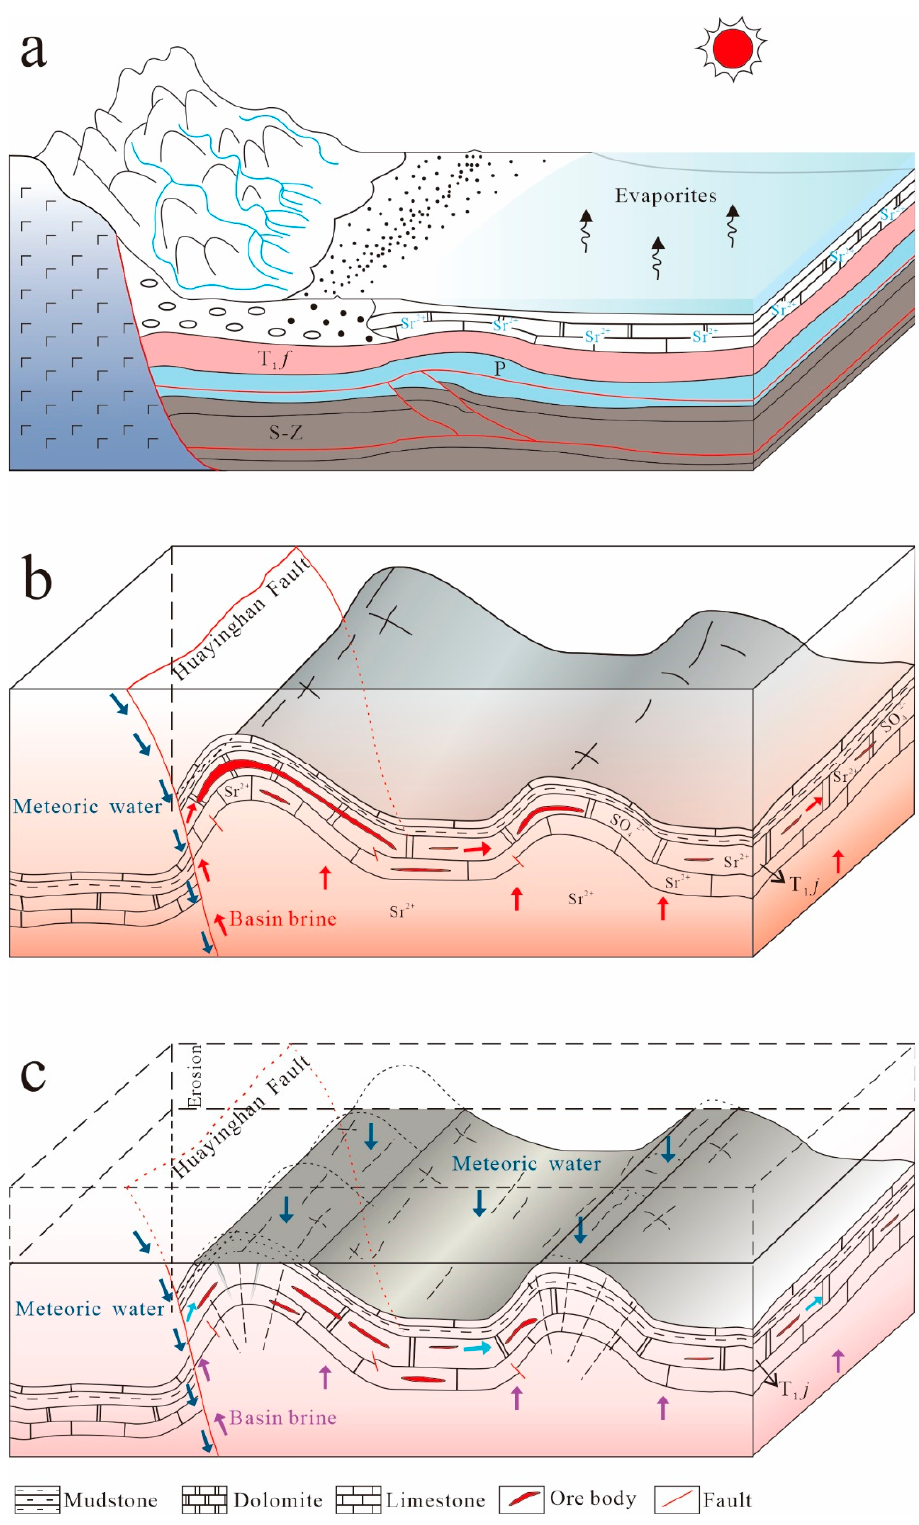
Figure 14. Metallogenic model for the celestine deposits in the Huayingshan area. ( a ) sr is enriched in carbonate rocks during the evaporation of seawater. ( b ) the brine in the basin replaced gypsum to form celestine during the migration process. ( c ) in the supergene stage, meteoric water dissolved part of the celestine ore bodies. The detailed description of subfigures ( a – c ) in the Section